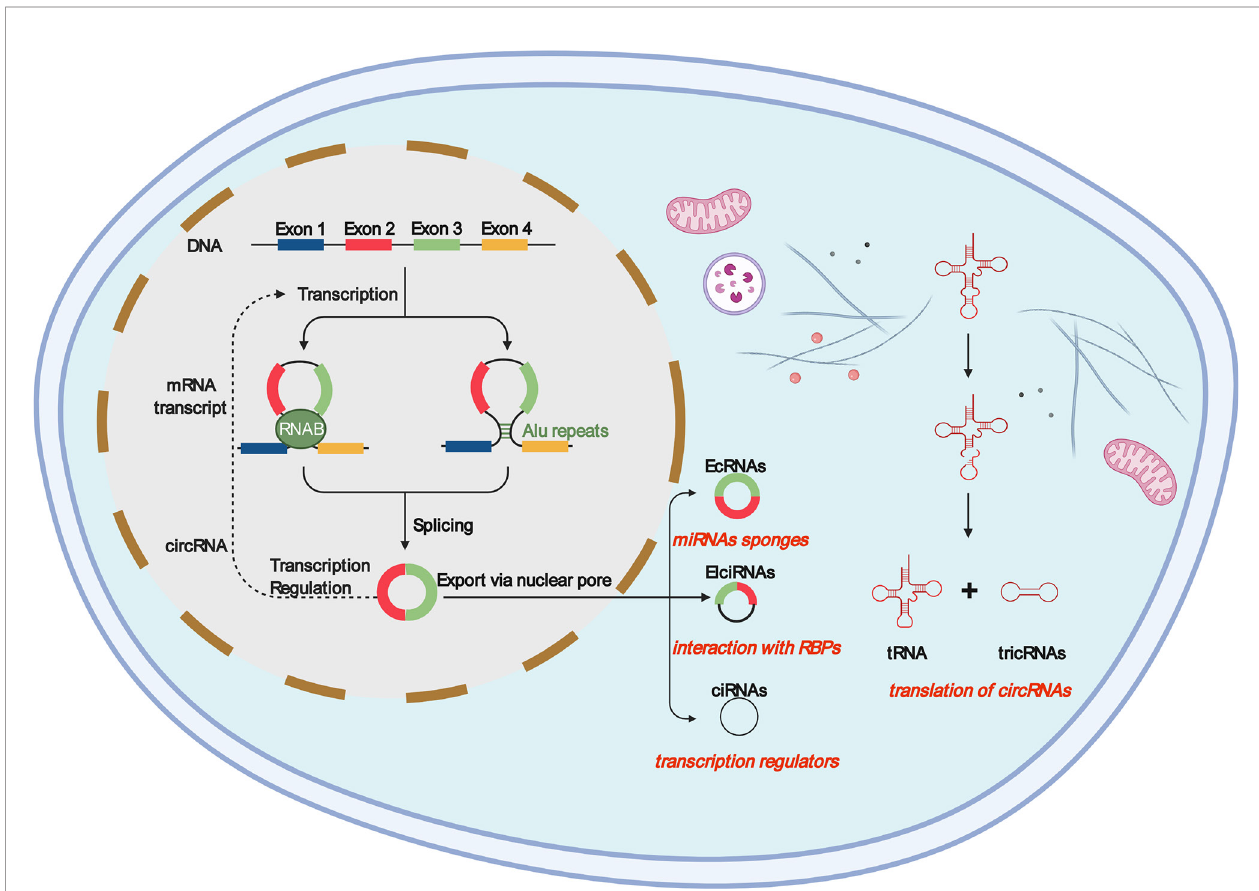
FIGURE 1 | Most ecircRNAs are primarily producedfromtwo or three exons of reverse splicing, in which the3 ′ splicing donor of thepre-mRNA iscovalent to the 5 ′ splicing receptor. Intron circular RNAs include circular intronRNAs (ciRNAs), excision of group I introns, excision of group II introns, excision of lariat introns, andexcision of tRNA introns. Exon – introncircular RNA isa circular RNA in whichexonsand intronsexist simultaneously. Internal repetitive sequences may playan important rolein its generation, possibly similar to ecircRNAs. Intergenomic circRNAs contain two intron circRNAs, fl anked by GT-AC splicing signals, which act as splicing donorsand acceptors of circRNAs and form a complete circRNA. Theresultingintron ends arejoined byRtcB ligase to form a stable circRNA,